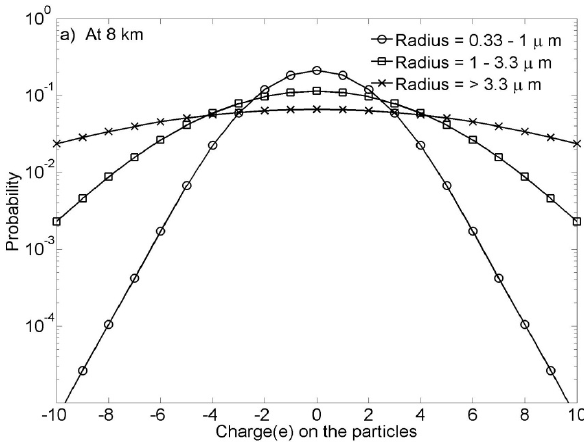
Fig. 3. The initial and final ion concentrations from modelling cal- culations.